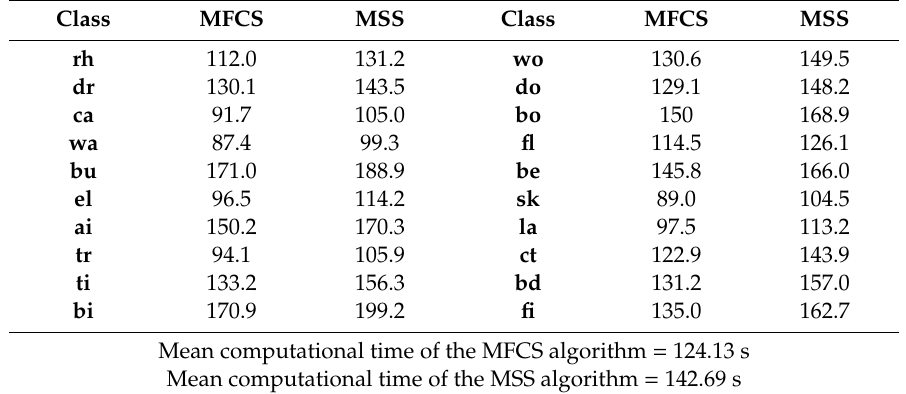
Table 3. Comparison of Computation Time for Object Segmentation Algorithms over Corel-10k